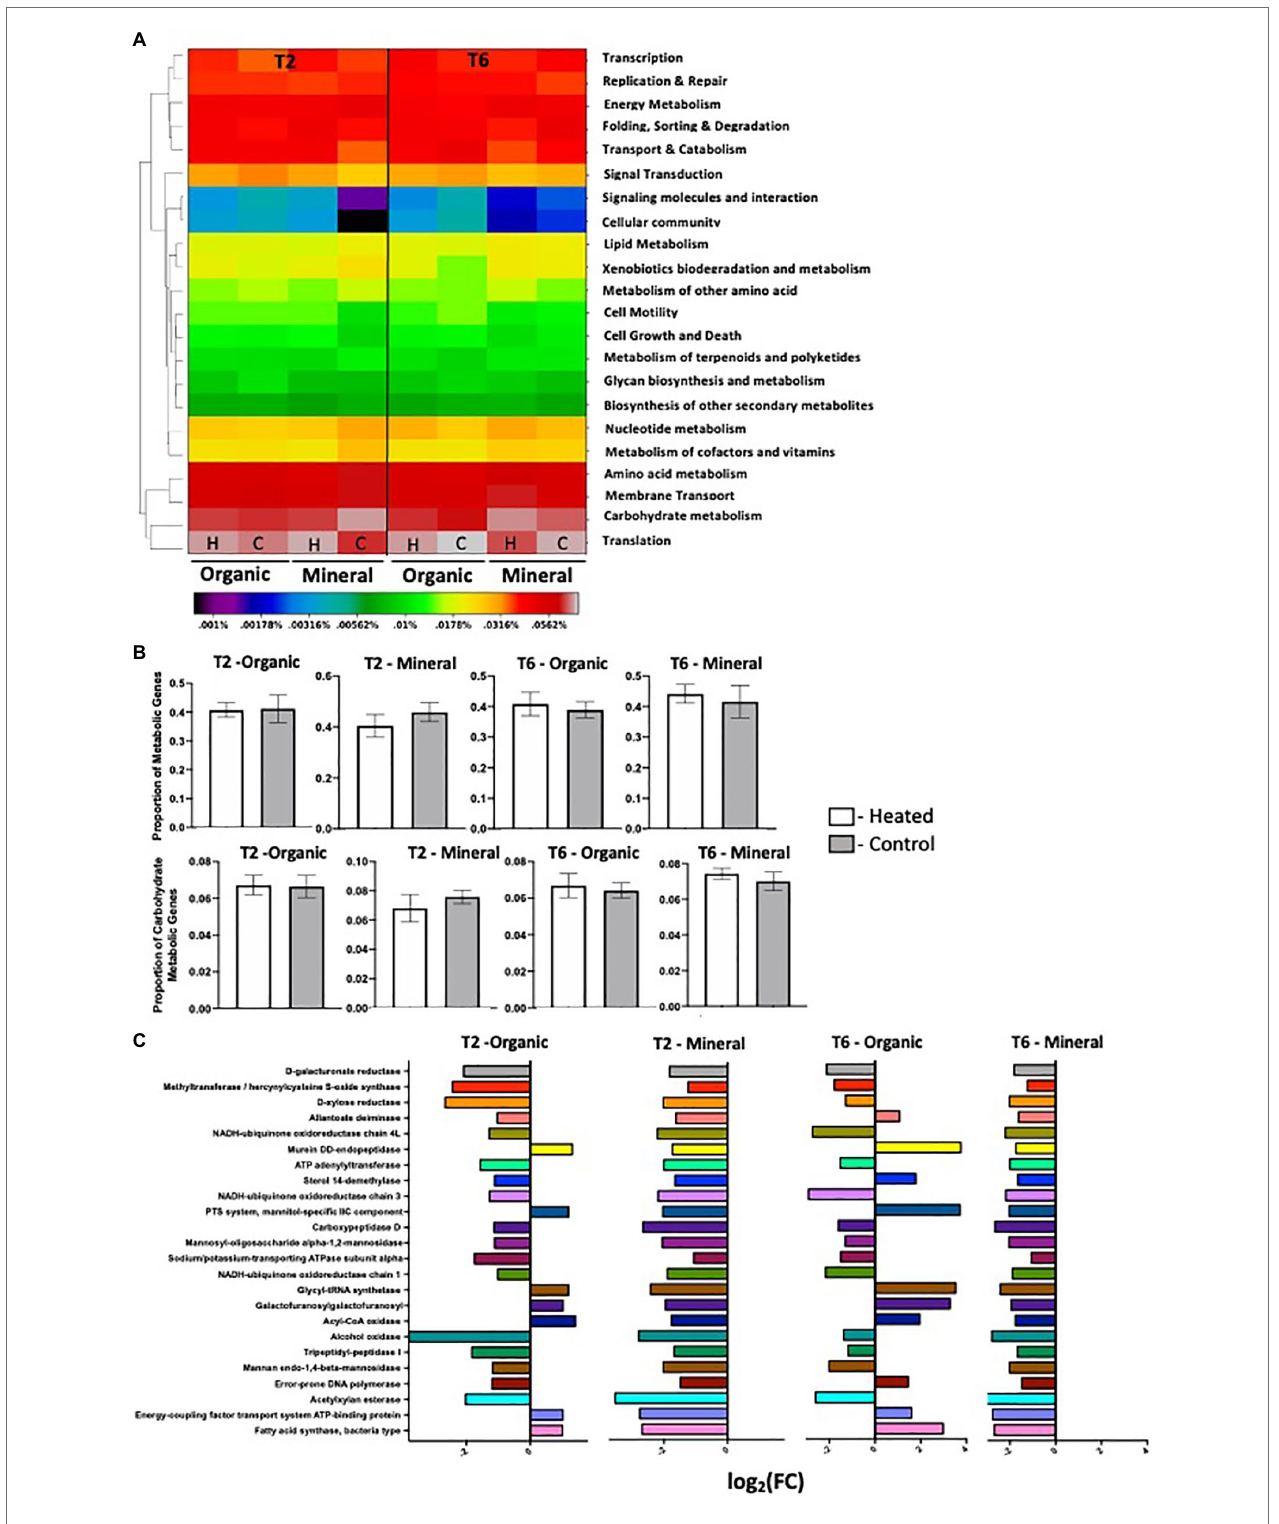
FIGURE 2 | KEGG annotations – (A) heat map showing the mean relative abundances of major KEGG categories in annotated transcripts across all eight treatment groups (H-Heated; C-Control). The dendrogram clusters the categories by common expression patterns using a two-way hierarchical clustering using the complete linkage method; (B) Mean relative abundances of transcripts annotated in KEGG metabolism category (Top Panel) and